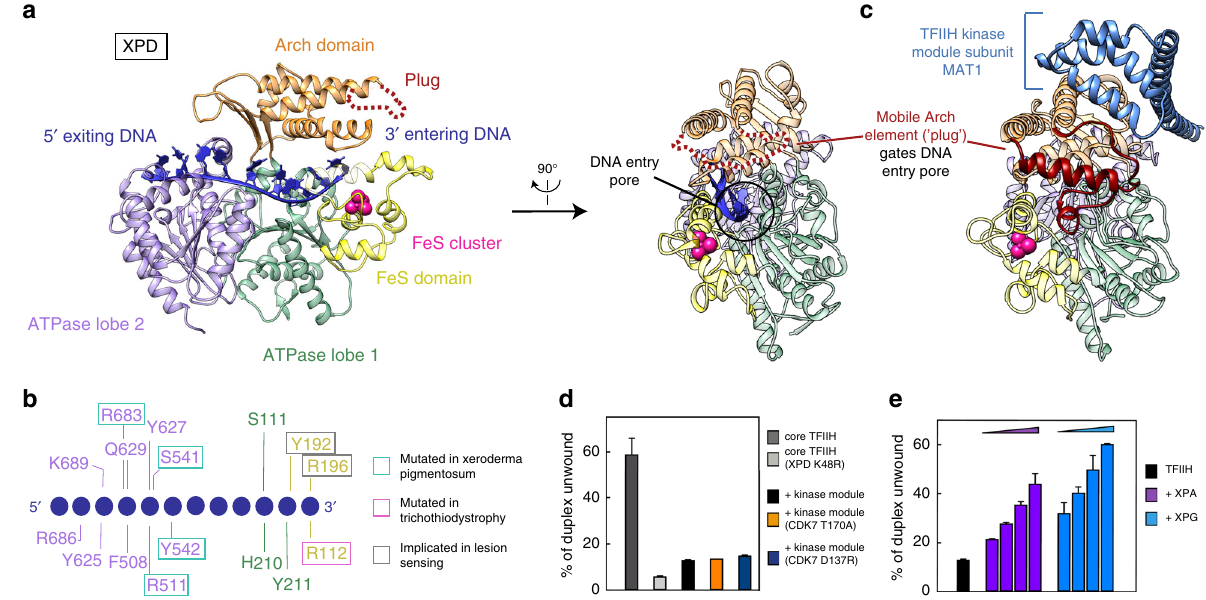
Fig. 4 XPD activation and DNA binding. a Two views of XPD bound to DNA. XPD domains ATPase lobe 1, FeS, Arch, and lobe 2 are in green, yellow, orange, and medium purple, respectively. DNA is dark blue. A black circle depicts the DNA pore. b Schematic representation of XPD – DNA interactions. c Side view of XPD bound to the kinase module (PDB code 5OF4) 6 . The plug in the Arch domain is in dark red, the kinase module subunit MAT1 in blue. d Effect of kinase module variants on XPD helicase activity. Core transcription factor IIH (TFIIH) was incubated with two-fold excess of the kinase module and helicase activity was monitored as in Fig. 1a. Bars show the percentage of unwound product after 300 s ( n = 2, error bars indicate the range of the data). Source Data are provided in the Source Data fi le. e Effect of increasing concentrations of XPA and XPG on XPD helicase activity in the